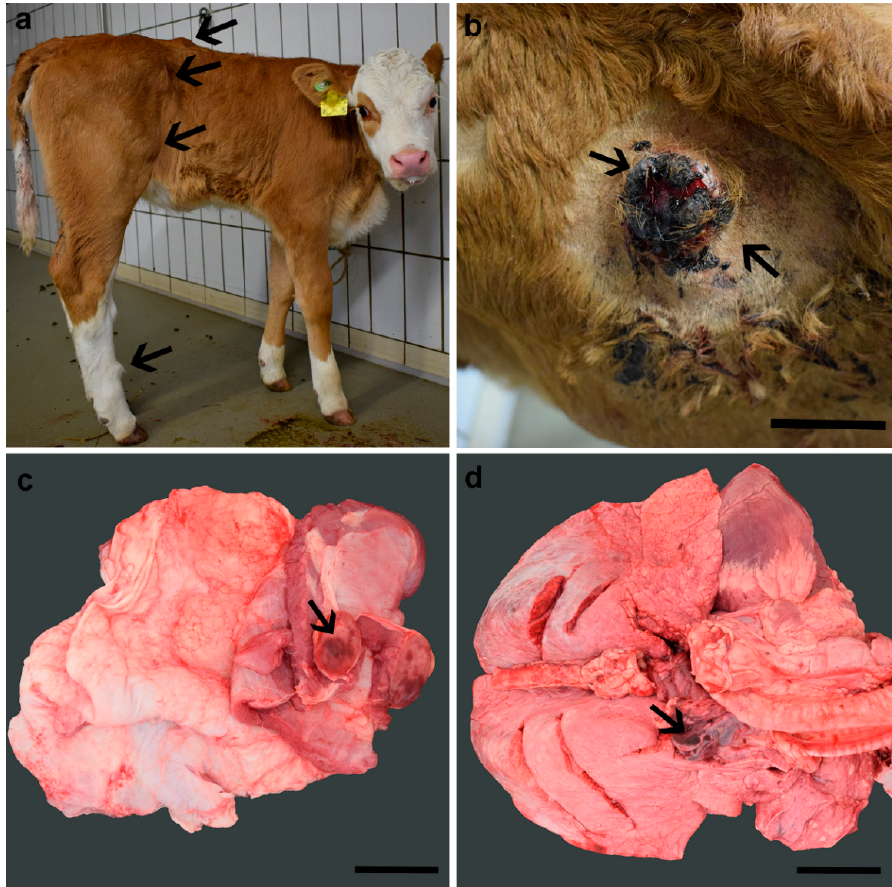
Figure 1. Cutaneous and subcutaneous nodules (arrows) located at the back, flank, and hindlimbs of the Simmental calf ( a ), some of which were covered by abundant serosanguineous crusts ( b ). At necropsy, similar looking nodules (arrows) were identified, namely in the inner thoracic wall ( c ) and in the mediastinum ( d ). All nodules measured up to 5 cm in diameter, were well demarcated from the adjacent tissue, and displayed a white to reddish cut surface. Bar 5 cm ( b ), 3 cm ( c ), and 4 cm ( d ).